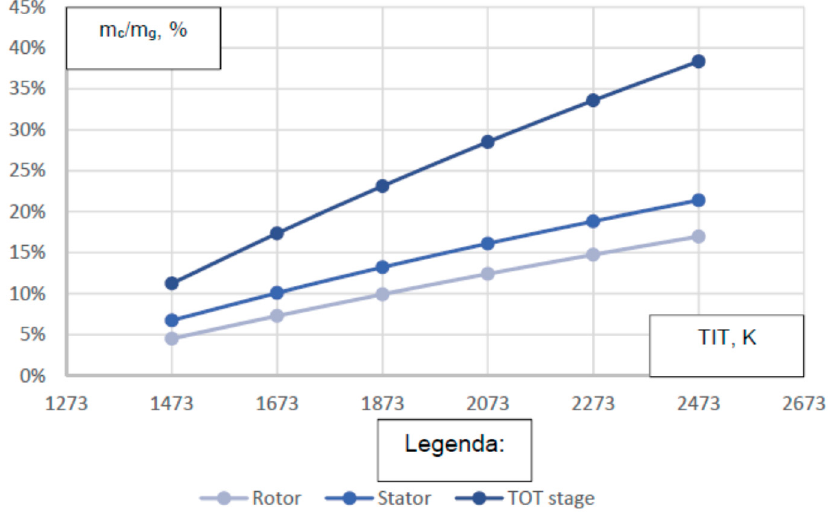
Figure 4. Coolant mass flow rates ((total turbine expansion ratio (PR) = 30).